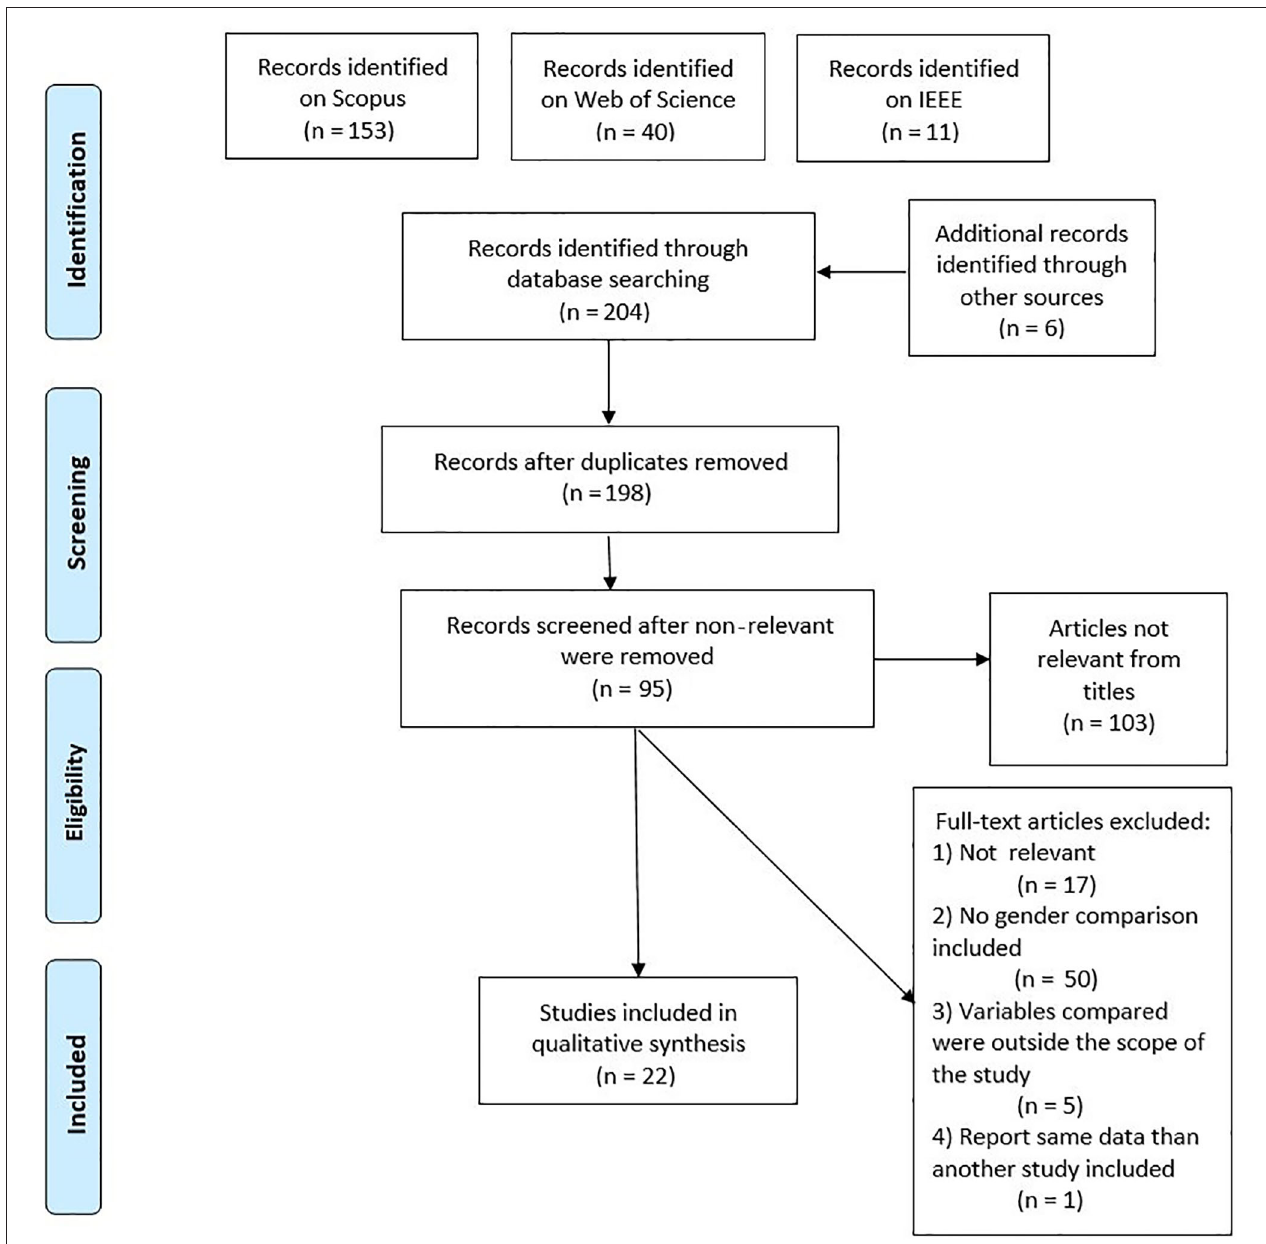
FIGURE 1 | Overview of the article selection